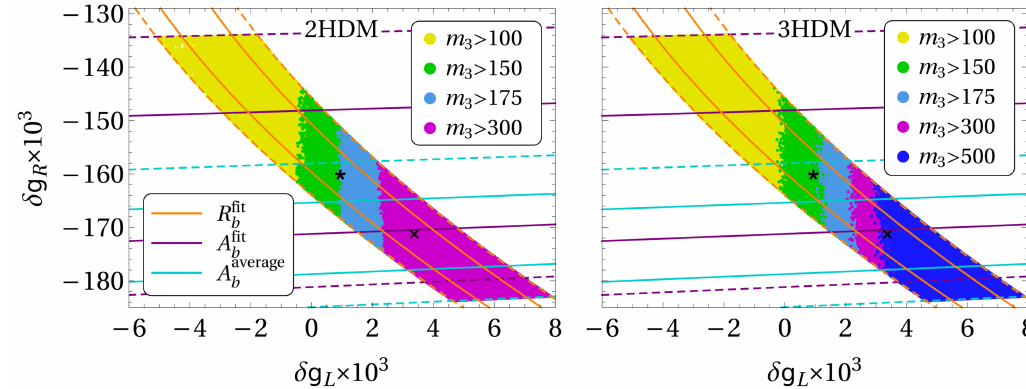
Figure 10 . Scatter plot of values of δg L and δg R in the aligned 2HDM (left panel) and in the aligned 3HDM (right panel) that suit the solution 2 for R and A . All the points depicted comply b b with the S and T -oblique parameters constraint of equation (3.16). A star marks the best-fit point of solution 2 fit , and a cross the best-fit point of solution 2 average . The orange lines mark the 1 σ (full lines) and 2 σ (dashed lines) boundaries of the region determined by the experimental value (1.10a); similarly, the violet lines correspond to the value (1.10b) and the light-blue lines to the value (1.11). Blue points have new neutral scalars heavier than 500 GeV, pink points have them heavier than 300 GeV, light blue points have the lightest new neutral scalar in between 175 GeV and 300 GeV, green points have it in between 150 GeV and 175 GeV, and yellow points have it between 100 GeV and 150 GeV.